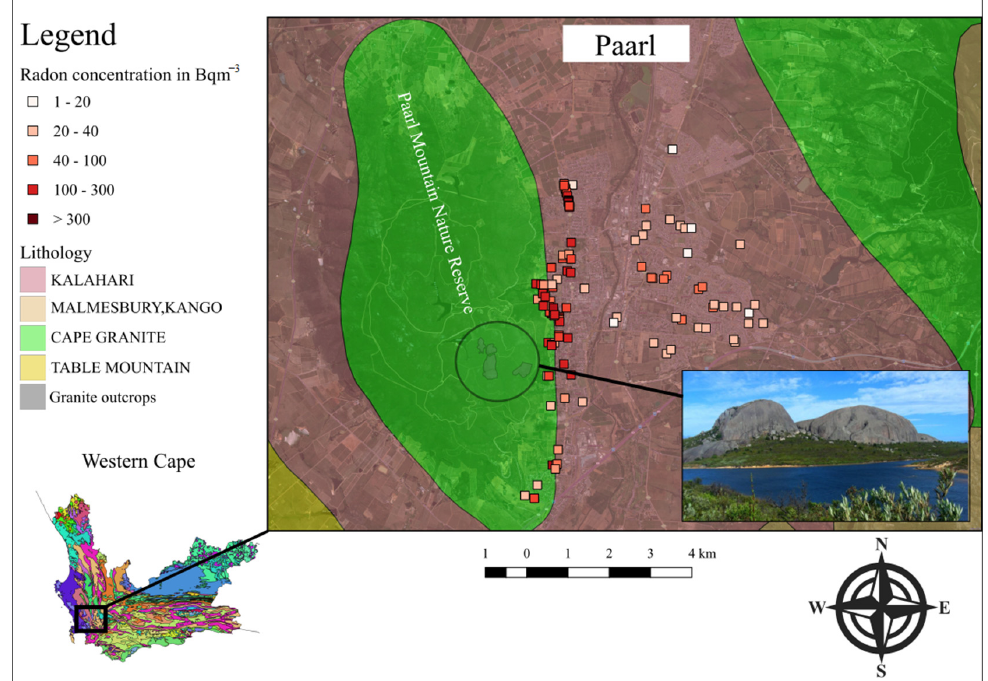
Figure 6. Indoor radon concentrations and the surrounding geology of the Paarl area.